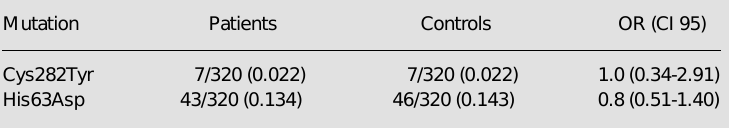
Table 2 - Allele frequencies of HFE mutations in controls and in patients with myocar- dial infarction (MI). Number of mutated chromosomes/number of chromosomes analyzed; allele frequen- cies are given in parentheses. None of the differences reached statistical significance (P>0.05). OR: Odds ratio for MI; CI 95: 95% confidence interval.